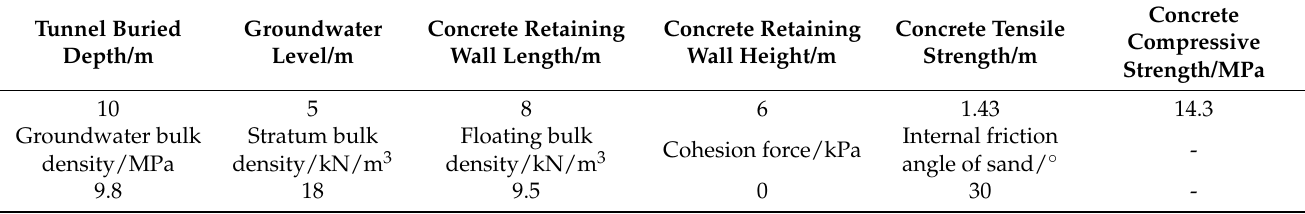
Table 1. Calculation parameters of the